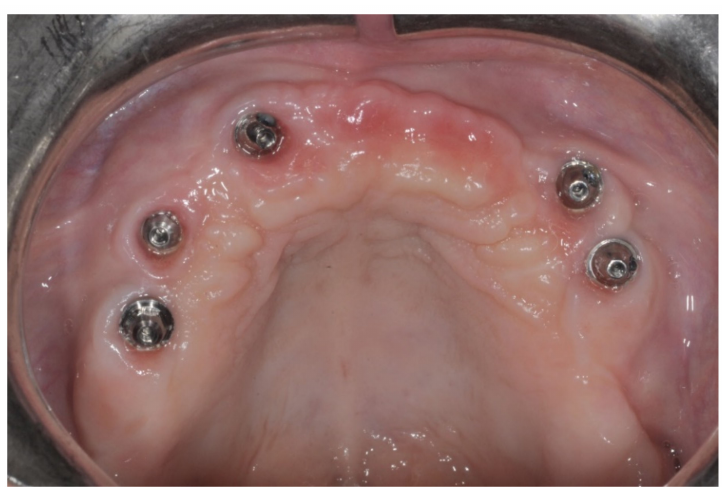
Figure 8. Clinical view after prosthetic loading. One additional implant was inserted when abutments were placed on the four originally inserted